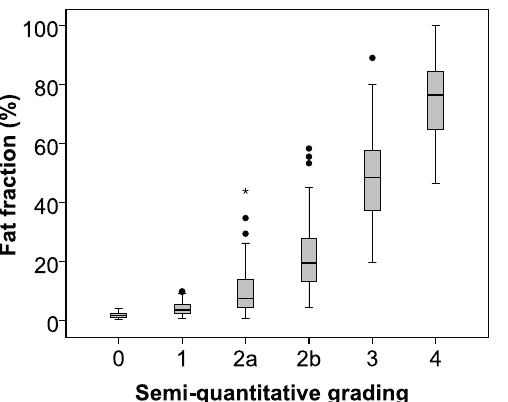
Figure 5. This figure compares the results of quantitative Dixon imaging with the semi-quantitative grading, demon- strating the wide range of fat fractions that can exist within the same grade (r s =0.87, p , 0.01). The grey bars represent the middle 50% of the distribution between the upper and lower quartile and their corresponding fat fraction. The dots and stars represent outliers beyond 1.5 and 3.0 times the interquartile range beyond the upper quartile respectively.